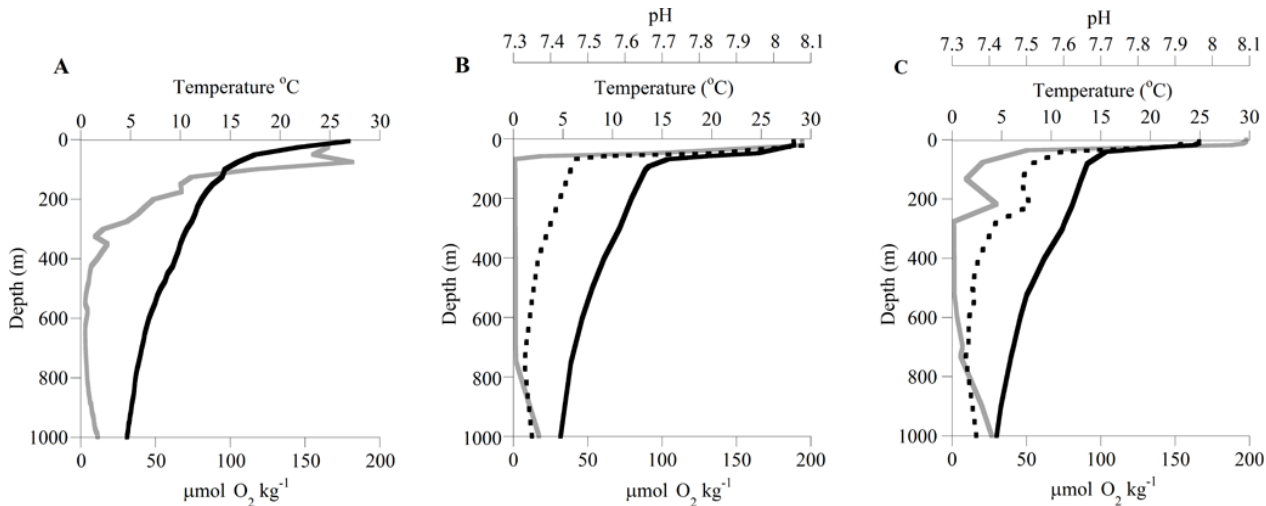
Fig. 1. A typical temperature ( ◦ C, black) and O 2 (µmolkg − 1 , grey) profile for the Gulf of California in June 2007 (A) , the Tehuantepec Bowl (B) , and the Costa Rica Dome (C) . The profiles from the Tehuantepec Bowl and the Costa Rica Dome are from 2008 and also show a pH profile (dashed